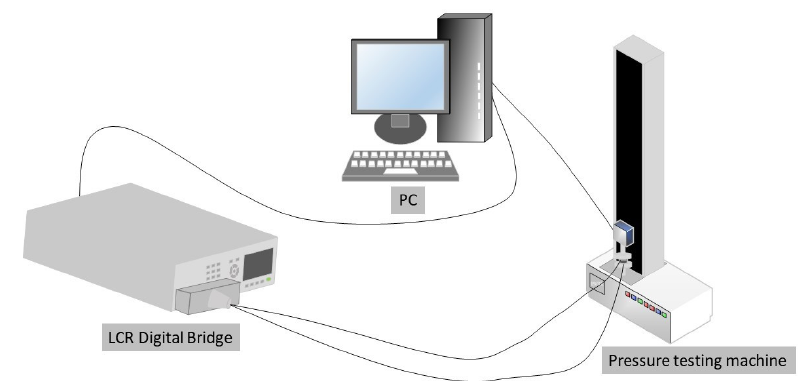
Figure 3. Resistance creep test system.